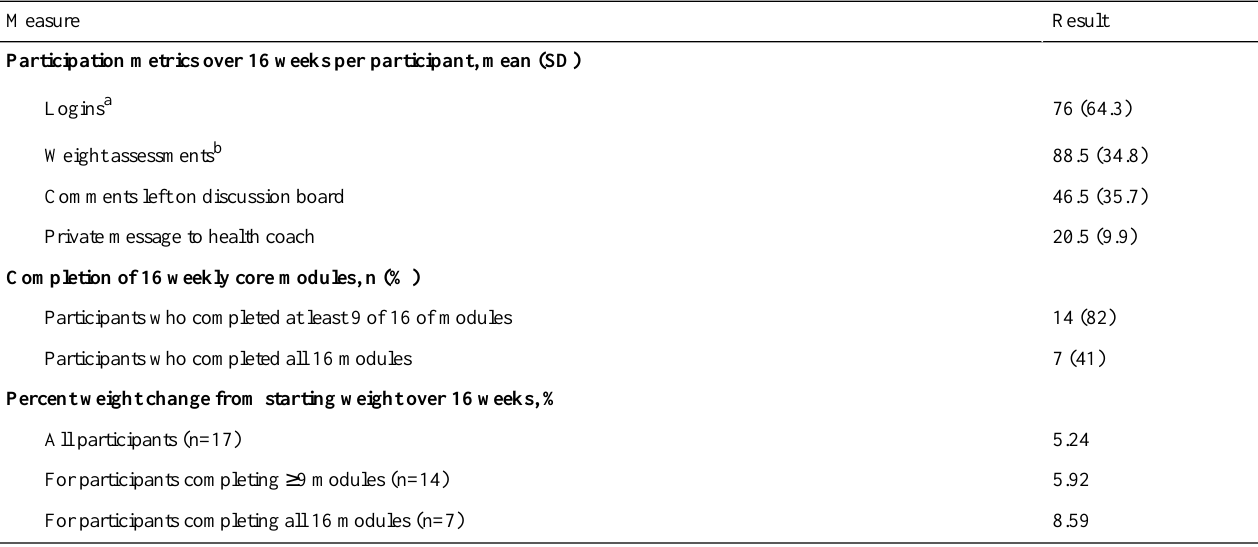
Table 2. Participation, engagement, and weight change over 16 weeks (n=17).